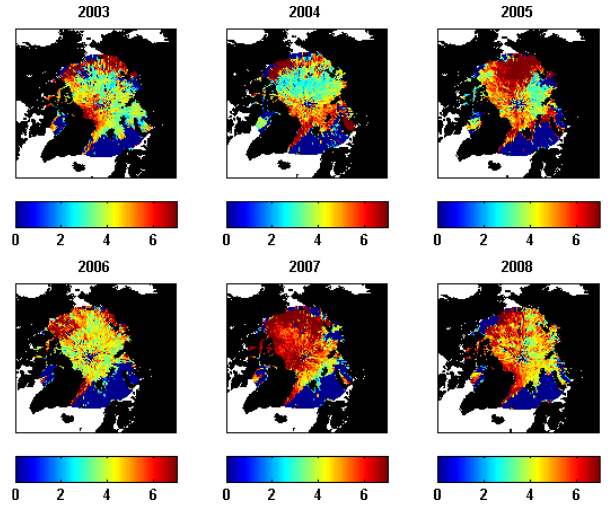
Fig. 8. Same as in Fig. 7, but for the month of July.